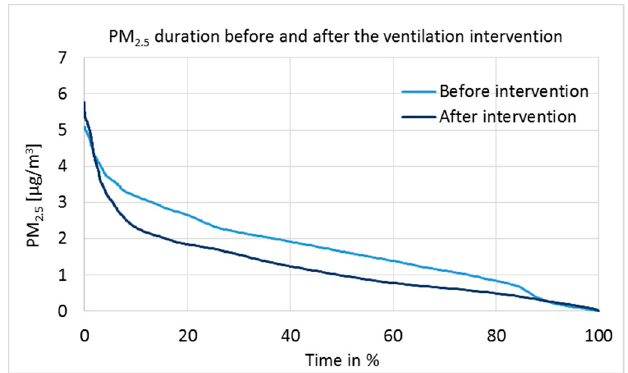
Figure 8. Duration curves of particulate matter 2.5 µ m before and after the ventilation intervention in Classroom 3 during one week. Table 6. PM 2.5 concentrations in Classroom 3 before and after the ventilation intervention: Statistical parameters.